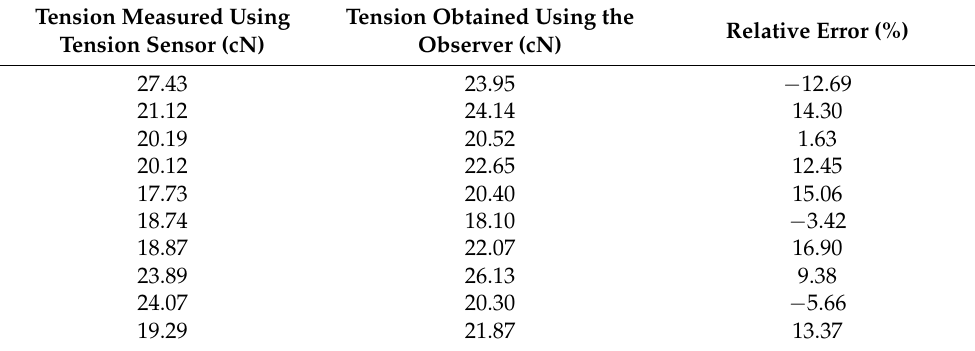
Figure 16. Comparisons between tension-observer tension observations. Table 2. Relative error of tension-observer observations.